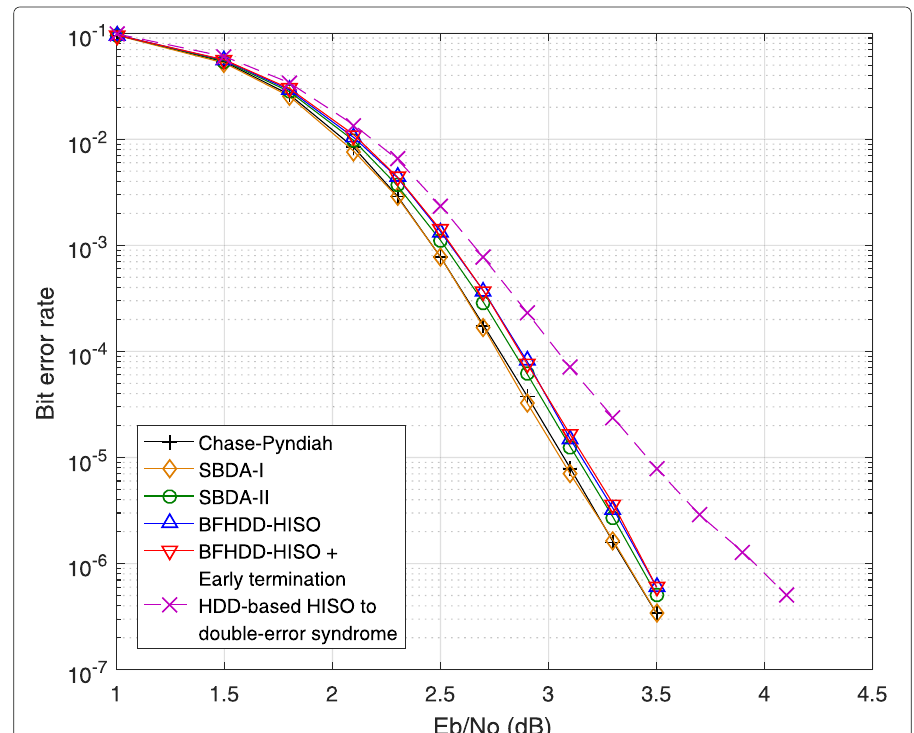
Fig. 11 Error correction performance results of different decoding algorithms of ( 32,26,4 ) 2 TPC ( I max ,8; LRB number,